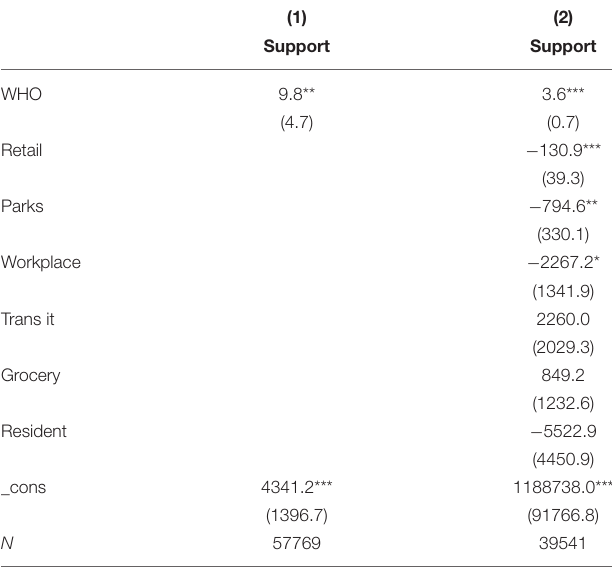
TABLE 3 | The impact of economic activity on economic support